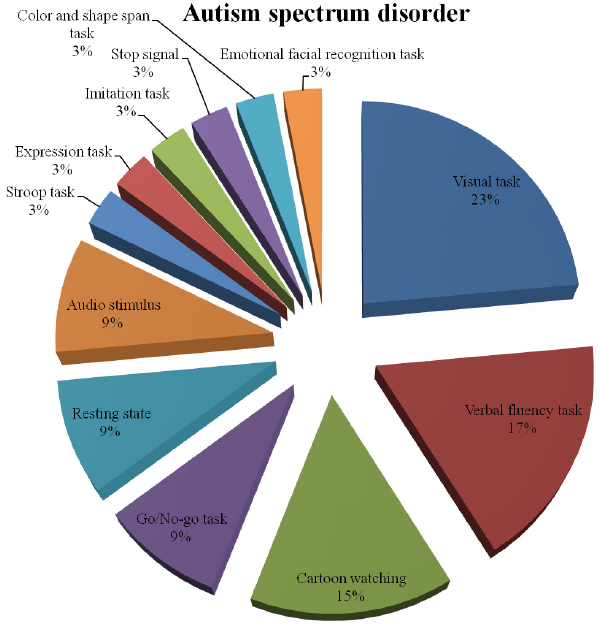
Fig. 1. Task-based distribution of studies on autism spectrum disorder (total studies: